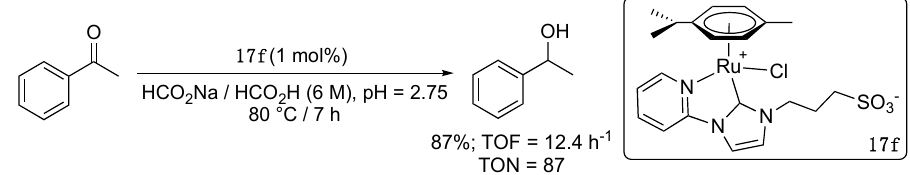
Figure 3. Pyridyl-functionalized imidazol-2-ylidene complexes 17 – 20 . The water-soluble derivative 17f of complex 17e , bearing a propylsulfonate substituent instead of a n -butyl group, was prepared by transmetalation from the corresponding silver carbene complex and applied as catalyst for the TH of acetophenone in aqueous medium using HCO 2 Na/HCO 2 H as buffer (6 M, pH = 2.75) and hydrogen source [31]. A moderate yield of 87% was obtained after 7 h reaction (TOF = 12.4 h − 1 ) at 80 °C with a catalytic charge of 1 mol% (Scheme 12). Notably, the Cp*Rh analogue proved much more active in this case, affording a 96% yield in only 10 min (TOF = 576 h − 1 ) under these conditions.